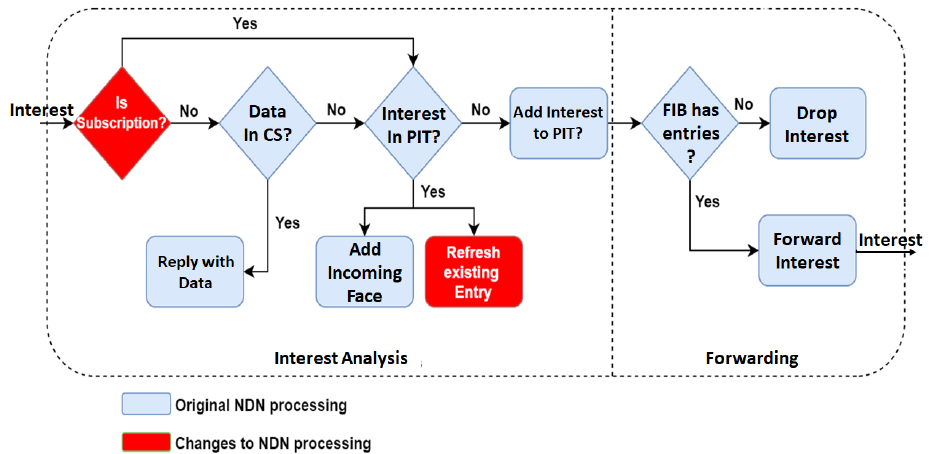
Figure 6. ndnIoT-FC pub-sub subscription request workflow.